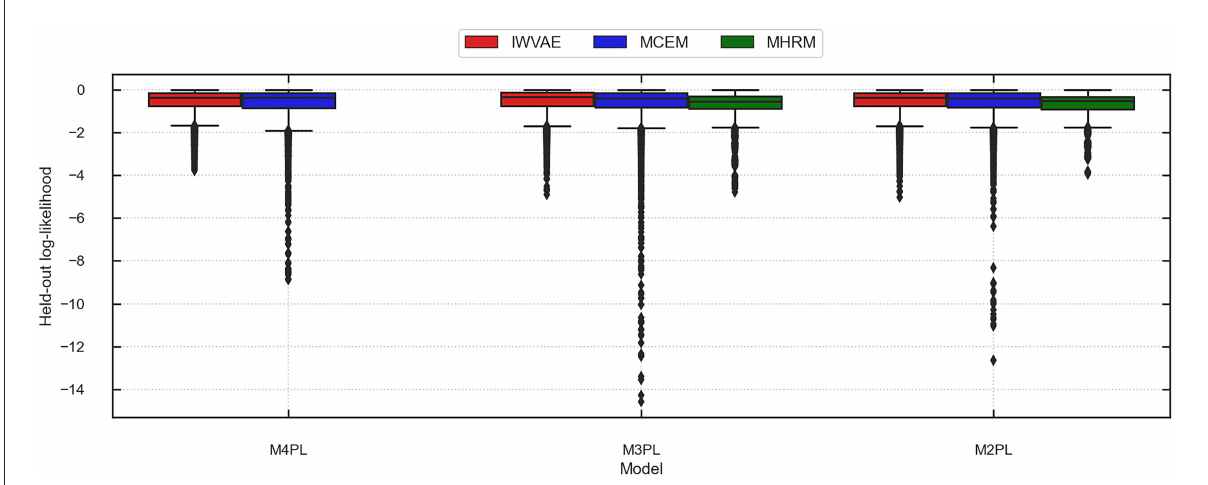
FIGURE4 Predicted log-likelihood on held-out items using different methods (IWVAE, MHRM, MCEM) to fit different MIRT models on MST data from a randomly selected trial. Outlier predictions are kept.